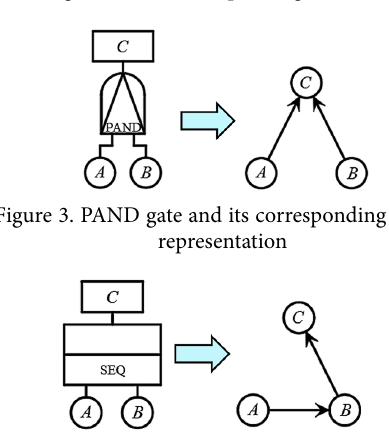
2. OR gate and its corresponding CTBN representation